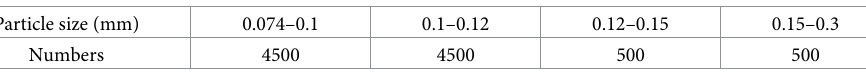
Table 5. The third type of particle